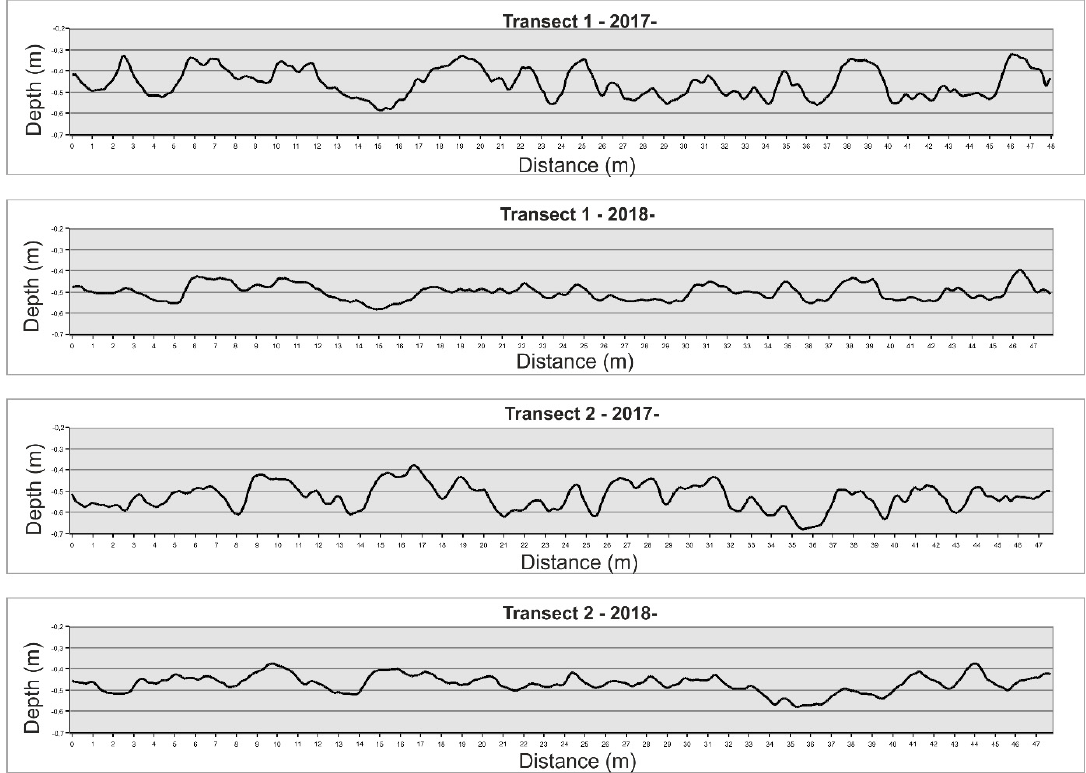
Figure A2. Comparison of terrain profiles along the two transects, T1 and T2, in Area 2 (Figure 8) between 2017 and 2018.